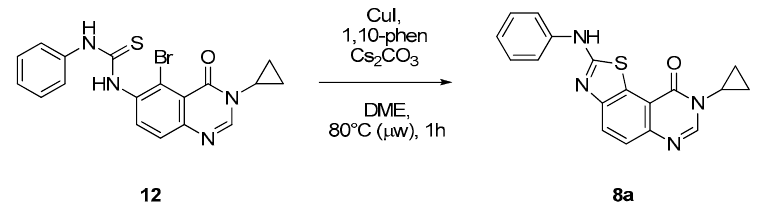
Table 3. Experimental condition optimization for the intramolecular metal-catalyzed cyclization of 12 . Entry CuI (mol %) Ligand a Cs 2 CO 3 (